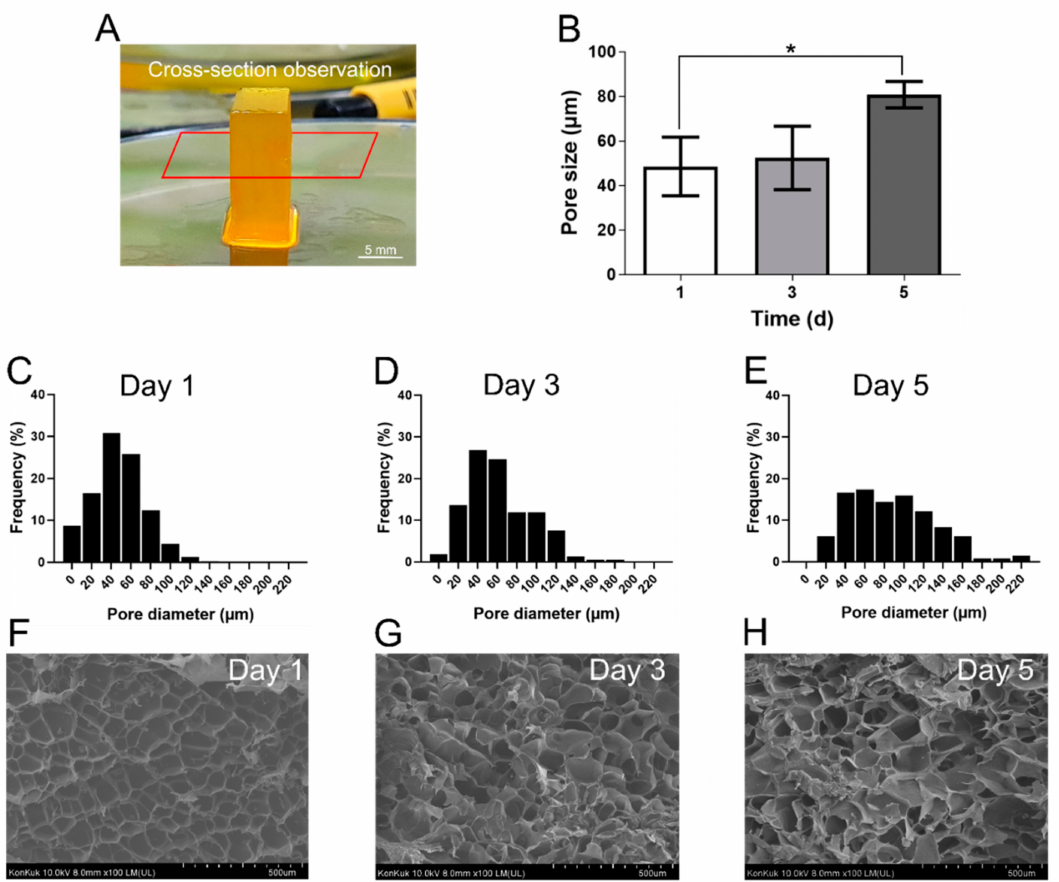
Figure 4. ( A ) Test sample for cross-section and observation planes (red rectangle). ( B ) Average pore size according to time courses: 1, 3, and 5 d. * p < 0.05 between the indicated groups. Data are shown as means ± SD, n = 3. ( C – E ) Pore distribution frequency obtained from SEM images of Z-stacked sca ff old prepared under di ff erent time points: 1, 3, and 5 d. ( F – H ) SEM images of pore structure according to